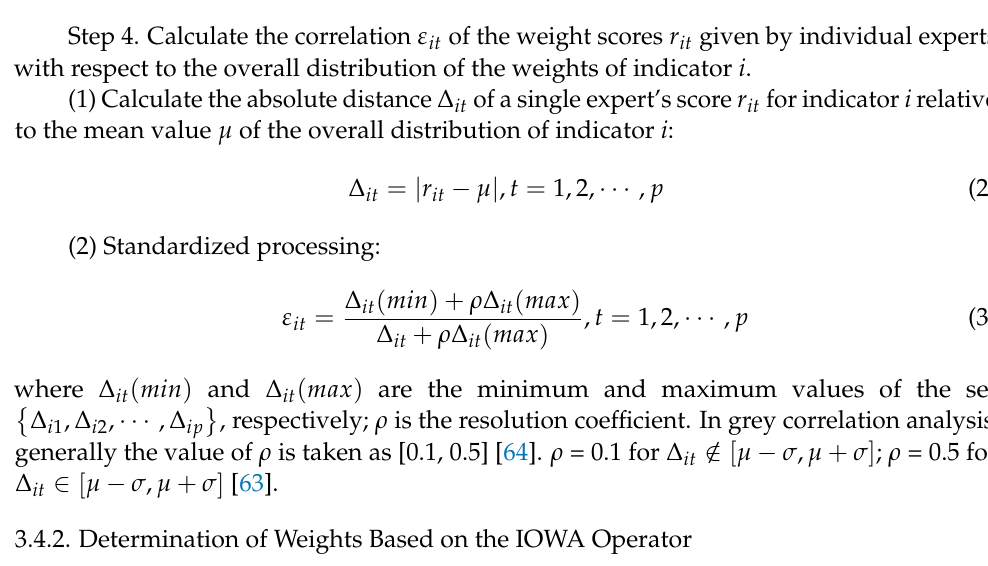
Figure 3. Sample distribution probability.